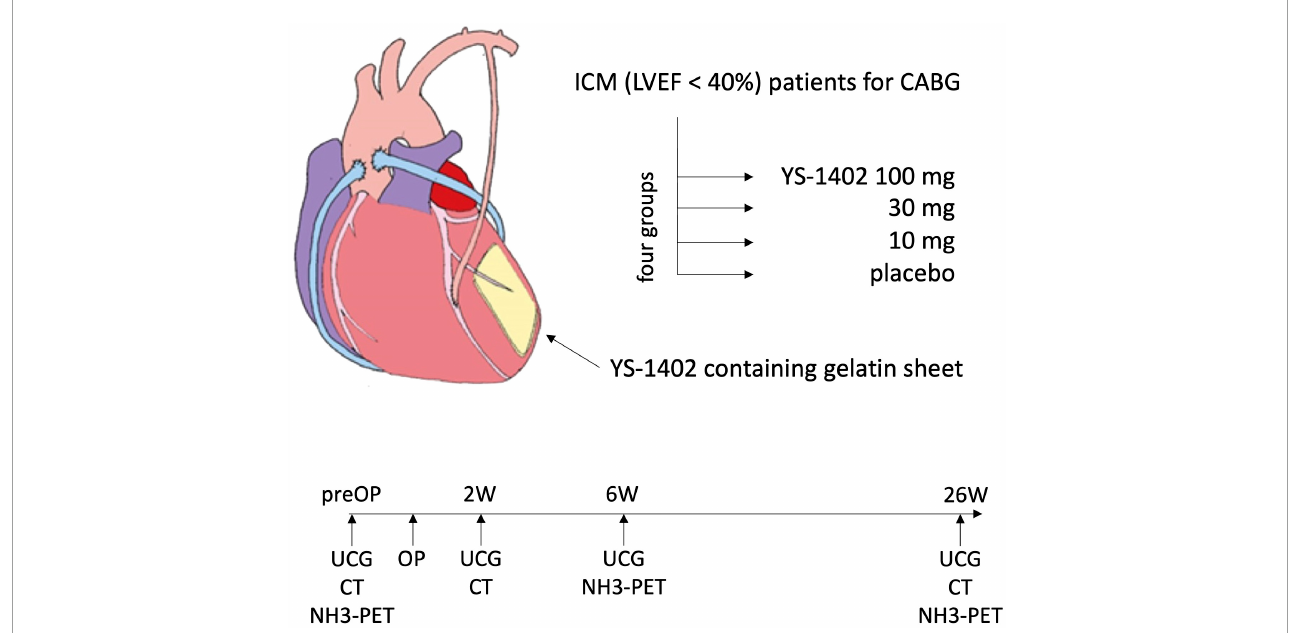
FIGURE4 Study scheme. ICM, ischemic cardiomyopathy; LVEF, left ventricular ejection fraction; UCG, ultrasonic